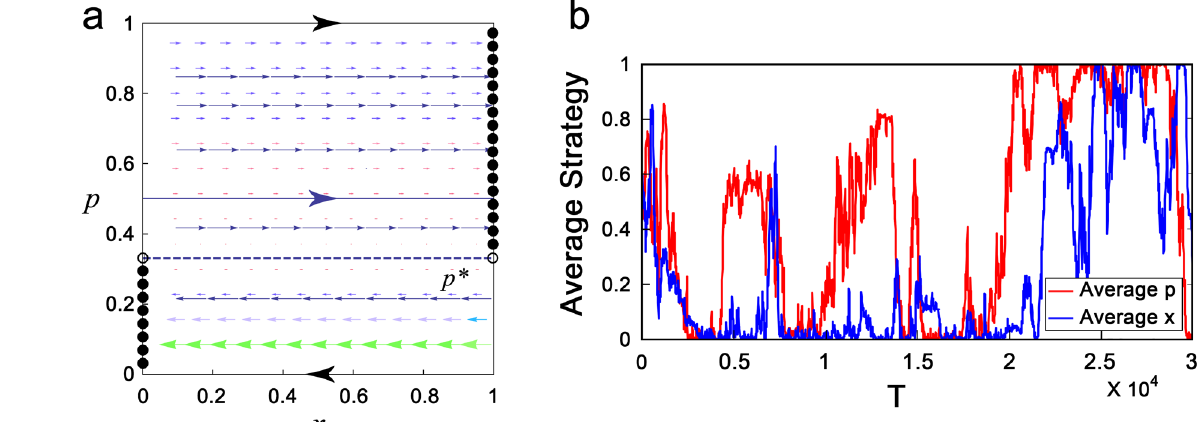
Fig 4. The evolution of conformity in the repeated PGG. Repeated PGG with n = 10, m = 4 and r = 1.6. (a) Phase portrait of the adaptive dynamics Eq (4). Stable equilibria and unstable equilibria are marked by solid dots and empty dots, respectively. p * = 1/3 (the blue dash line). A trajectory of Eq (4) starting from ( x , p ) converges to the stable cooperative equilibrium (1, p ) if p > p * , and converges to the unstable defective equilibrium (0, p ) if p < p * . (b) Monte-Carlo simulation result for a population of size 100. At the beginning of each time step, individuals are randomly divided into 25 groups and play the repeated PGG. In each time step, an average of 10 individuals are chosen to update, where they imitate actions that perform better with a probability proportional to the payoffs obtained in the repeated PGG. With probability 0.1, one of the 100 individuals is chosen to adopt a new strategy (i.e., the average individual mutation rate is 0.001) by adding a small random value (draw from Gaussian noise (0, 0.1)) on its former strategy. Monte-Carlo simulation also shows that conditional altruistic strategies (i.e., x = 1 with large p ) and unconditional selfish strategies (i.e., x = 1 with small p ) are bistable, and the population oscillates between x = 1 and x =